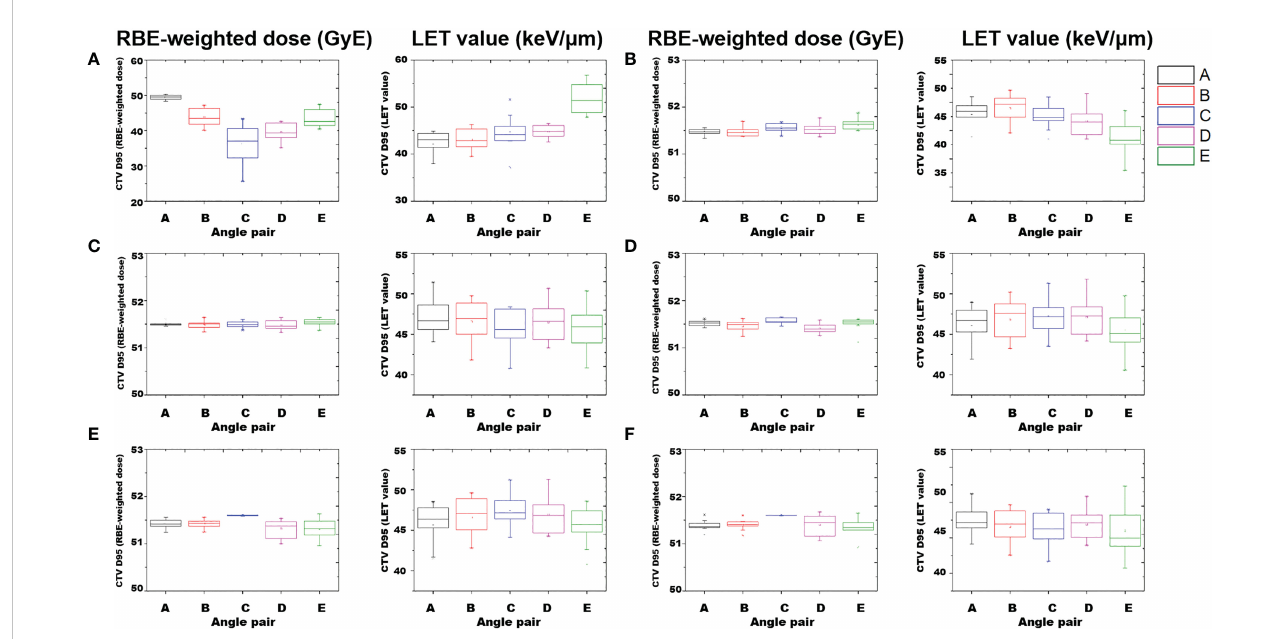
FIGURE 5 Box-plot of RBE-weighted dose and LET value of CTV D 95% according to angle pair A – E. Average and standard deviation, min, max values are indicated. Results of perturbed scenarios in 6 directions: (A) anterior, (B) posterior, (C) cranial, (D) caudal, (E) left, and (F)